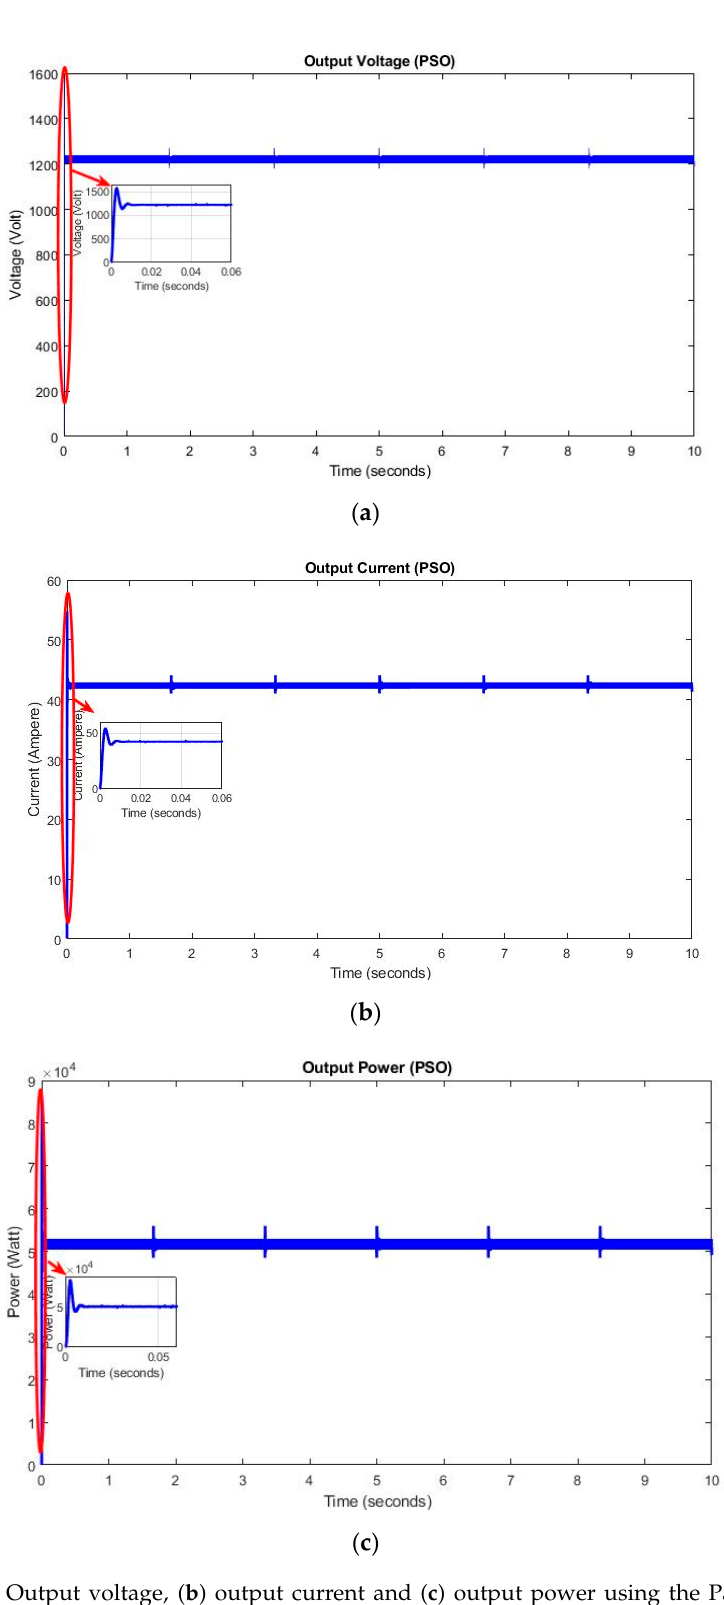
Figure 7. ( a ) Output voltage, ( b ) output current and ( c ) output power using the Particle Swarm Optimisation